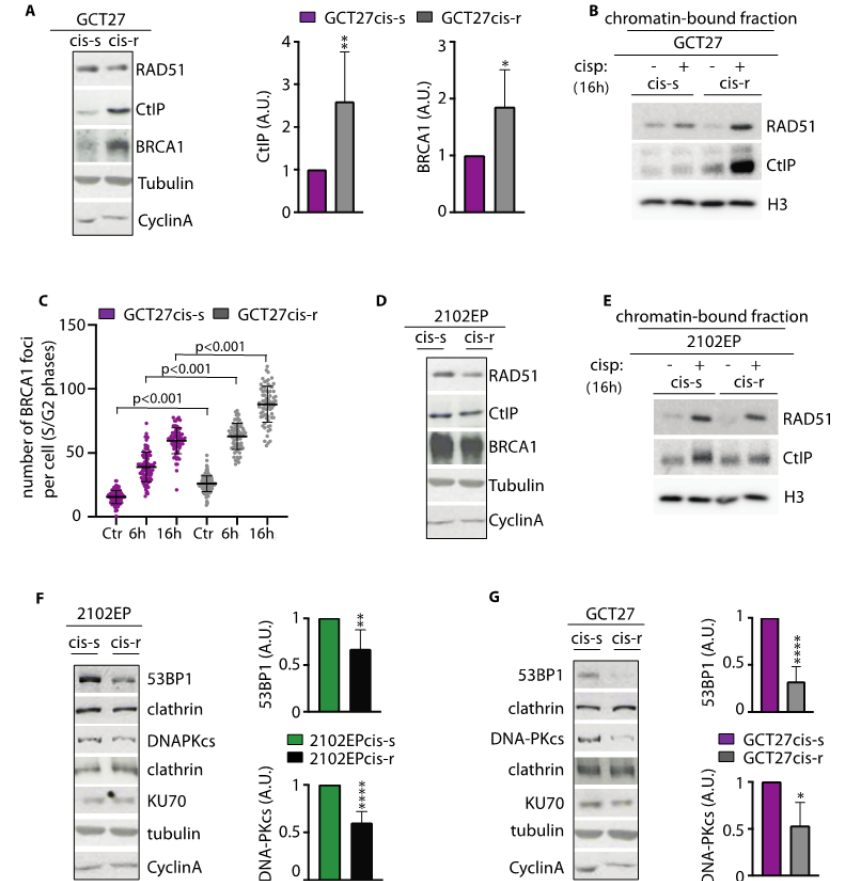
Figure 3. ( A ) Western blotting analyses of the indicated pro-homologous recombination (HR) factors in total cell extracts from GCT27 paired cell lines. Graph bars quantify protein level differences among GCT27 cell lines. Data are mean values ± s.d. of either three (breast cancer type 1 susceptibility pro- tein, BRCA1) or six (C-terminal binding protein-1 interacting protein, CtIP) independent experiments. Original blots see Figure S3C. Statistical analyses were performed using a two-tailed t -test (* p < 0.05; ** p < 0.01). ( B ) Western blotting analyses of the indicated pro-HR factors in chromatin extracts from GCT27 paired cell lines. Cells were treated with a pulse of 3 µ M cisplatin for 6 h and analyzed 16 h after culture in drug-free media. Histone H3 (H3) was used as a loading control. Original blots see Figure S3D. ( C ) Quantification of BRCA1 foci number in GCT27 paired cell lines before (Ctr) and after treatment with 3 µ M cisplatin. Treated cells were collected both at the end of treatment (6 h) and 16 h after drug washout. Data are mean values ± s.d. of two independent experiments, each performed in duplicate. ( D ) Western blotting analyses of the indicated pro-HR factors in total cell extracts of 2102EP paired cell lines. Tubulin and cyclin A were assessed to detect differences in protein loading and cell cycle phase distribution, respectively. Original blots see Figure S3C. ( E ) Western blotting analyses of the indicated pro-HR factors in chromatin extracts from the indicated cell lines, before and after treatment with 3 µ M cisplatin for 6 h. Cell extracts were prepared from cells collected 16 h after drug removal. H3 was used as a loading control. Original blots see Figure S3D. ( F , G ) Western blotting analyses of the indicated pro-non-homologous end joining (NHEJ) factors in total cell extracts of 2102EP and GCT27 cell lines. Clathrin was used as a loading control for 53BP1 and DNA-PKcs, while KU70 expression was normalized using tubulin. Graph bars quantify protein levels difference among cell lines. Original blots see Figure S3E. Data are mean values ± s.d. of six (53BP1) or three (DNA-PKcs) independent experiments. In all quantifications, the expression of the indicated proteins was normalized on the expression of either tubulin or clathrin. Cyclin A was assessed to detect possible differences in cell cycle phase distribution among cell lines. Statistical analyses were performed using a one-tailed t -test (* p < 0.05; ** p < 0.01; **** p < 0.0001). A.U. = arbitrary